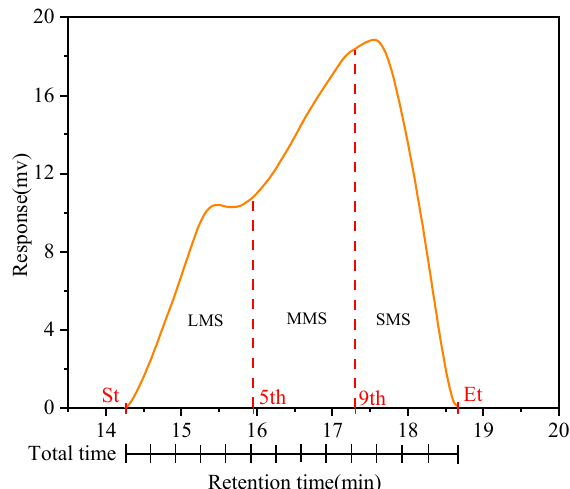
Figure 4. Methodology of analyzing molecular size.